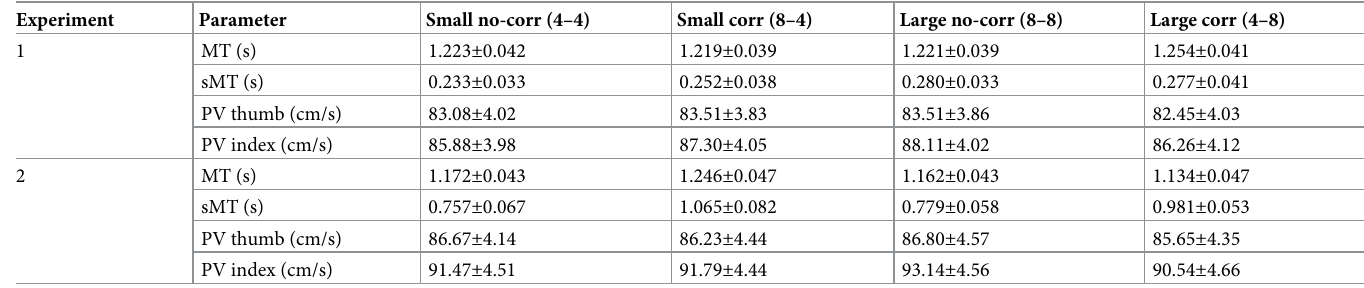
Table 1. Reaching parameters for Experiment 1 and